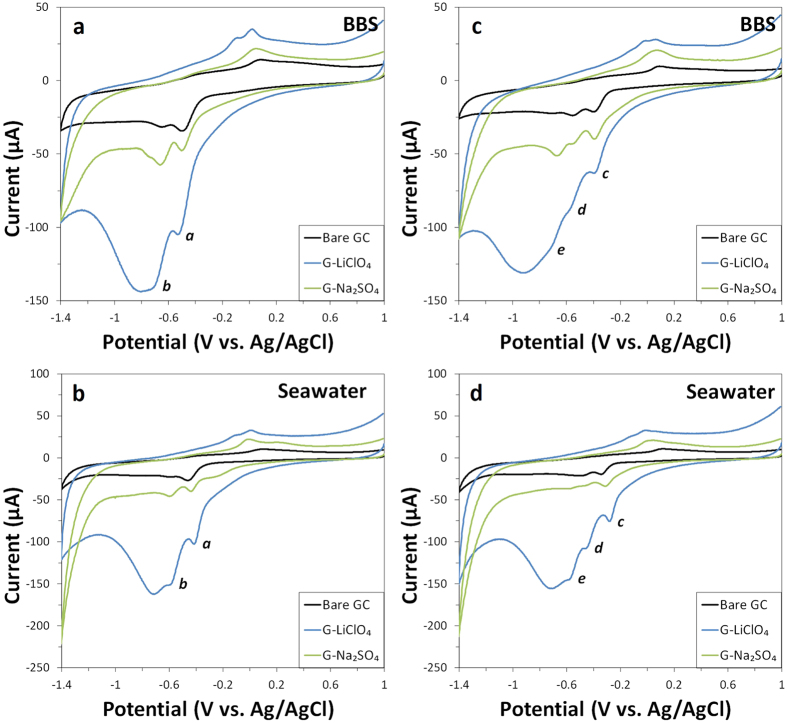
Cyclic voltammograms of DNT (20 ppm) (a,b) in (a) BBS and (b) seawater and TNT (20 ppm) in (c) BBS and (d) seawater at bare GC electrode and GC electrode modified with G-LiClO4 and G-Na2SO4. Conditions: (a,c) BBS (20 mM, pH 9.2) and (b,d) mixture of 9:1 volume ratio of seawater (pH 8.0) to BBS (200 mM, pH 9.2). Scan rate 100 mV s−1.